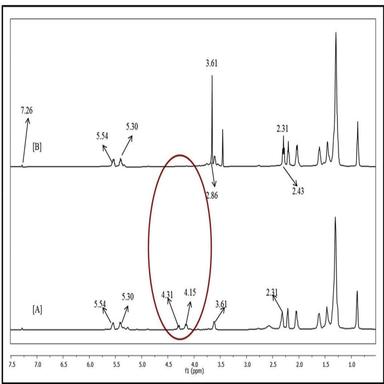
Comparison of chemical shift (PPM) 1 H NMR spectra: (A) crude Castor oil; (B) fatty acid propyl ester (biodiesel) for conversion of biodiesel at constant reaction parameters: 50 ± 1 C 24 h, 6:1 alcohol to crude Castor oil ratio and10% hybrid BSC on oil amount.